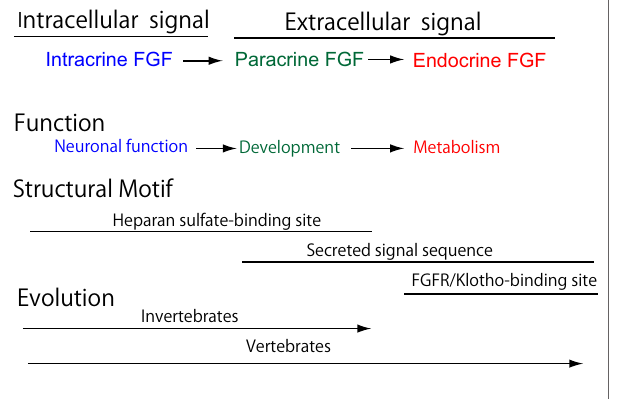
FiGURe 2 | The functional evolutionary history of the FGF family